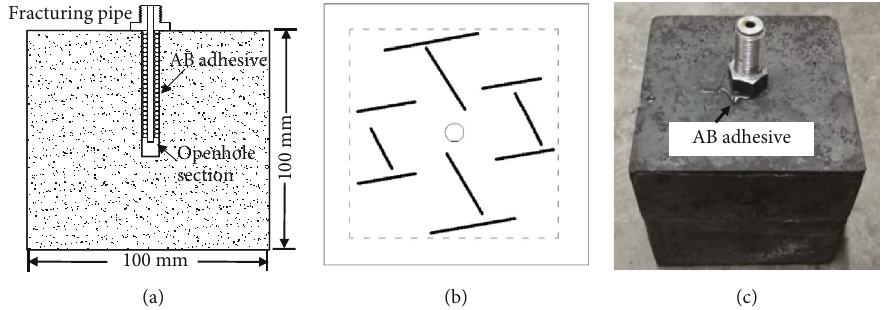
Figure 2: Production process of similar material specimen with fractures.